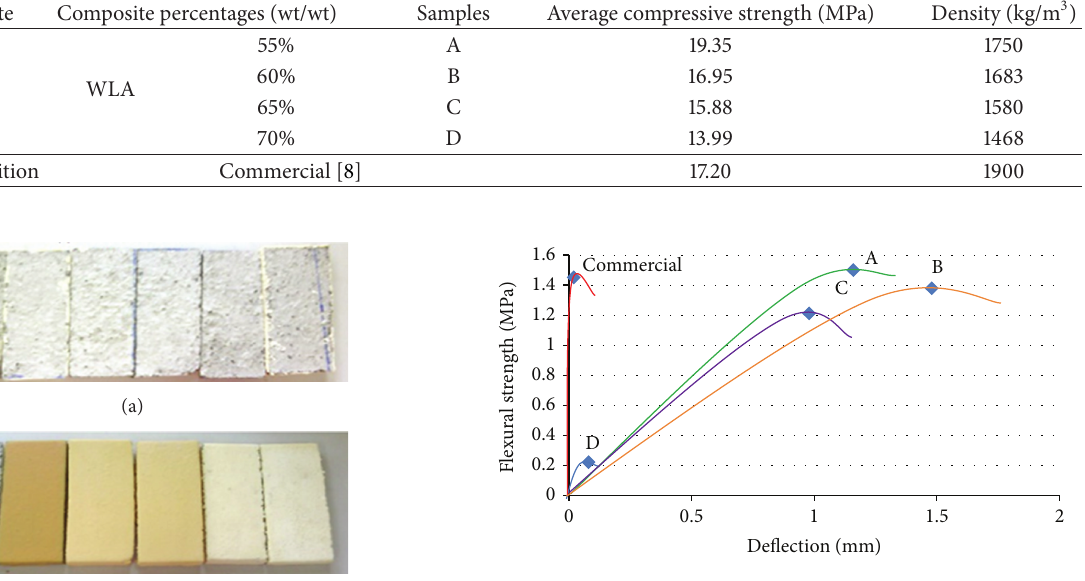
Figure 5: Flexural load against deflection of standard and light- weight cube concrete with different ratio of WLA to cement (wt/wt):